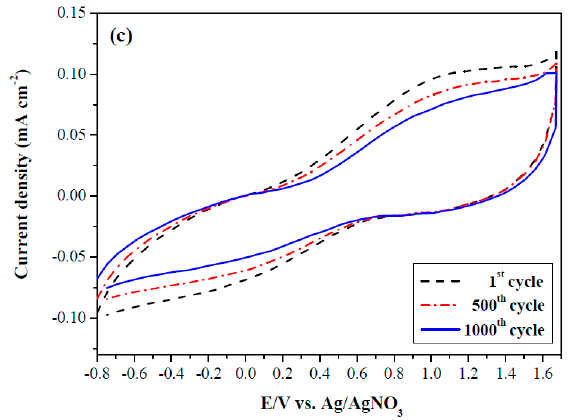
Figure 10. Cyclic voltammograms of ( a ) PdCz / PProdot-Me 2 ; ( b ) P(dCz2- co -dTC2) / PProdot-Me 2 and ( c ) PdTC / PProdot-Me 2 ECDs at a scan rate of 500 mV s − 1 between one and 1000 cycles.